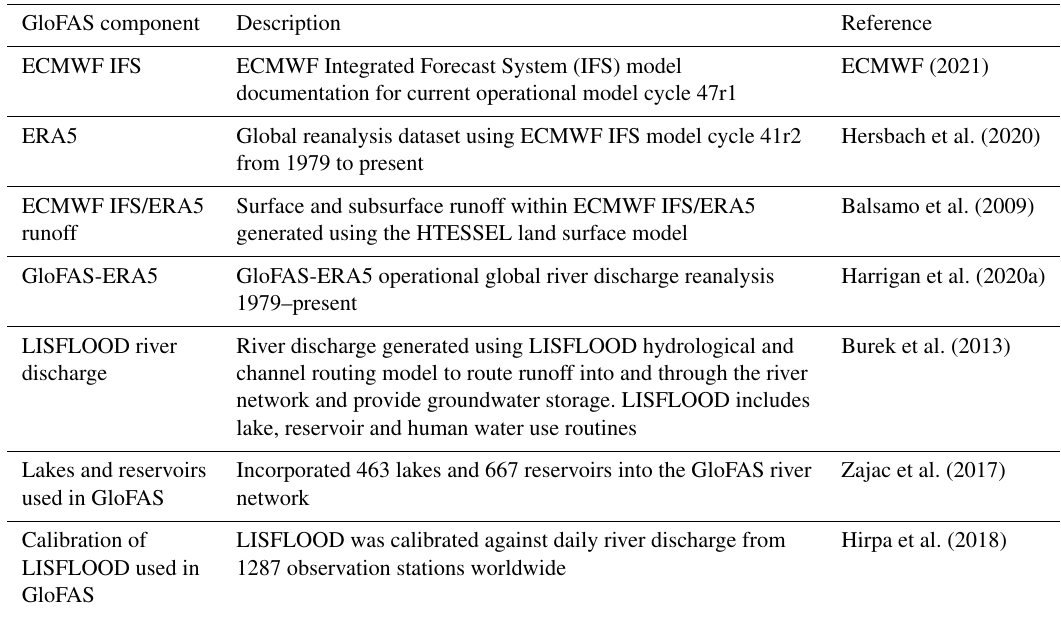
Table A1. Scientific papers and model documentation for the key GloFAS model components. Adapted from Harrigan et al.